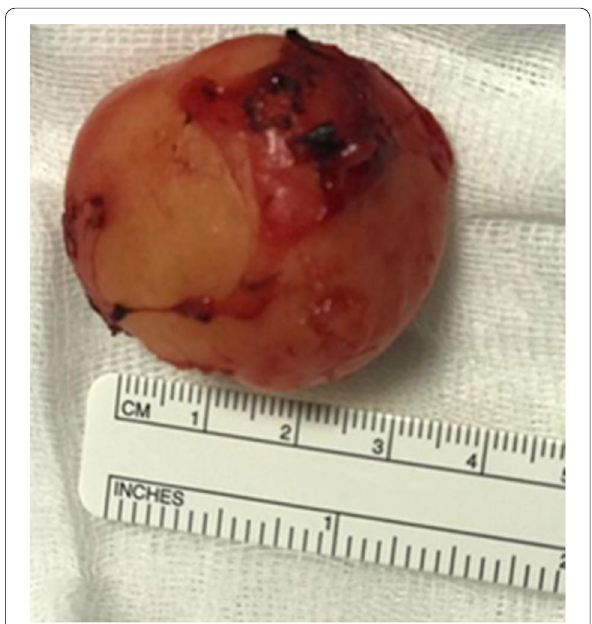
Fig. 5 A 32 35 encapsulated mass of firm consistency with an × homogenous, solid, yellowish white cut surface, histologically confirmed to be a